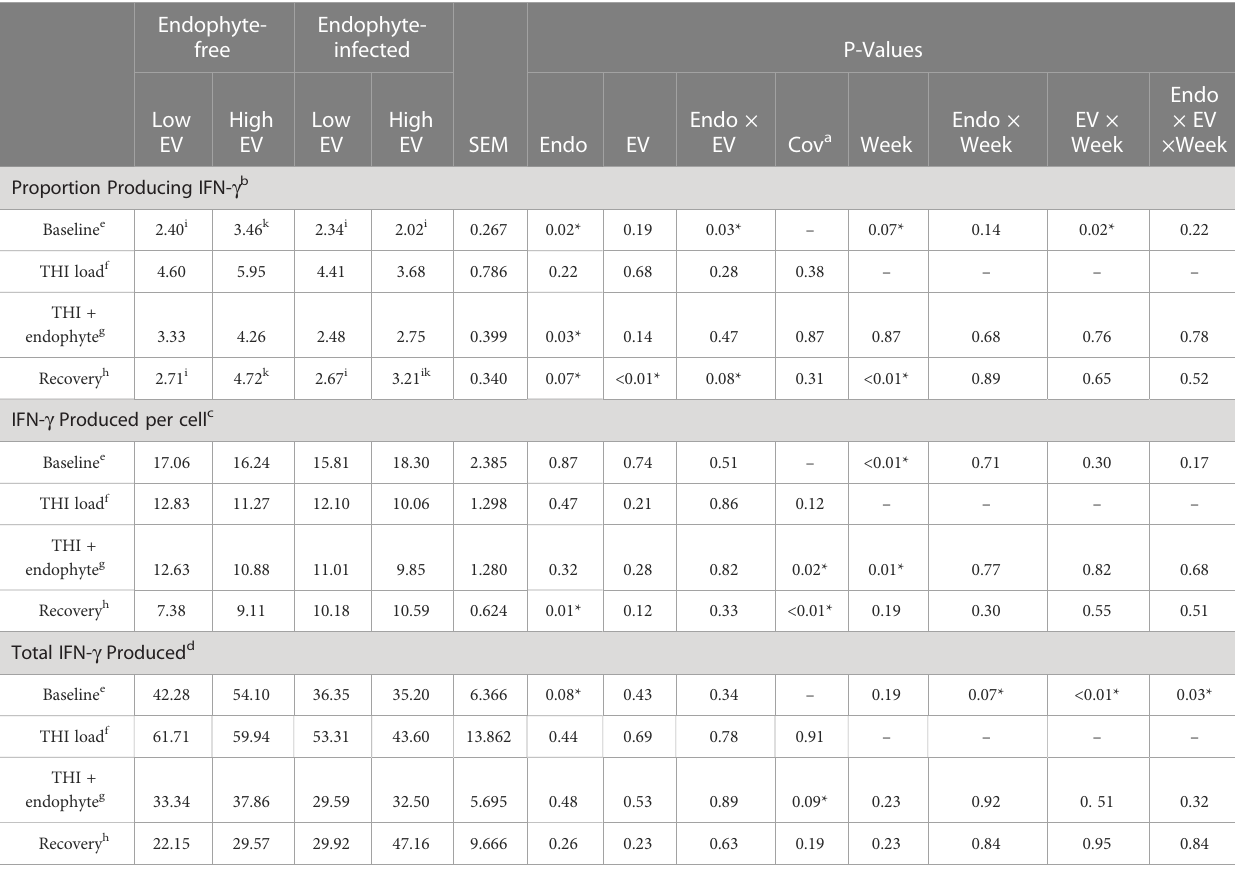
TABLE 3 Experiment 1 lymphocyte intracellular production of IFN- g in response to endophyte (Endo) and exit velocity (EV)